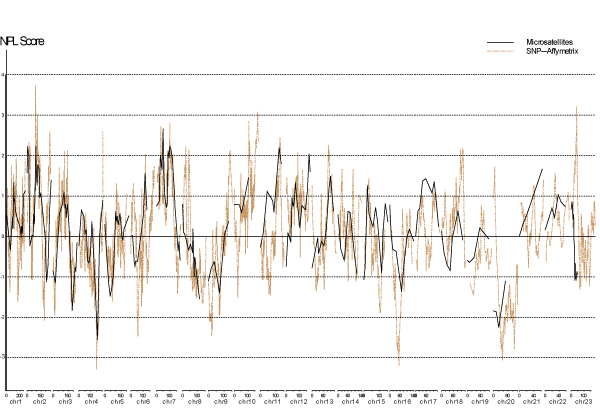
Genome-wide scans using microsatellite and SNP markers. NPL scores for microsatellite markers (solid line) and SNP markers (dotted line).